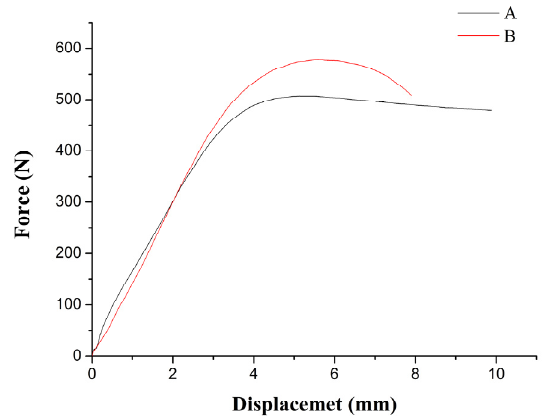
Figure 5. The force-displacement curve diagram of PP and TGMPP.